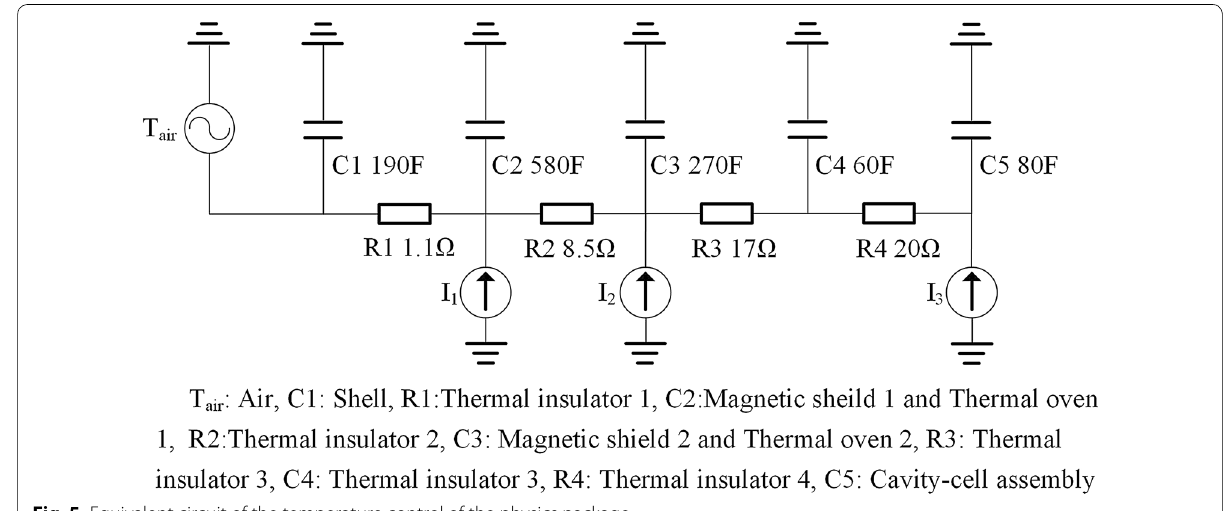
Fig. 5 Equivalent circuit of the temperature control of the physics